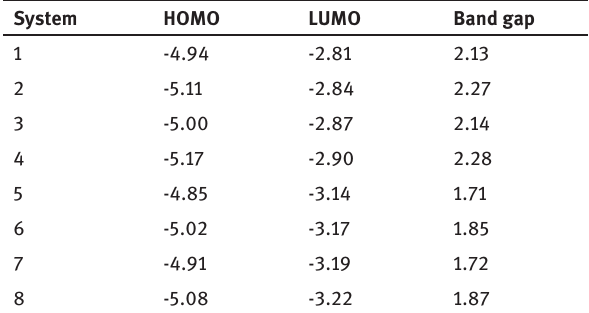
Table 1 : HOMO, LUMO and band gap of designed systems.